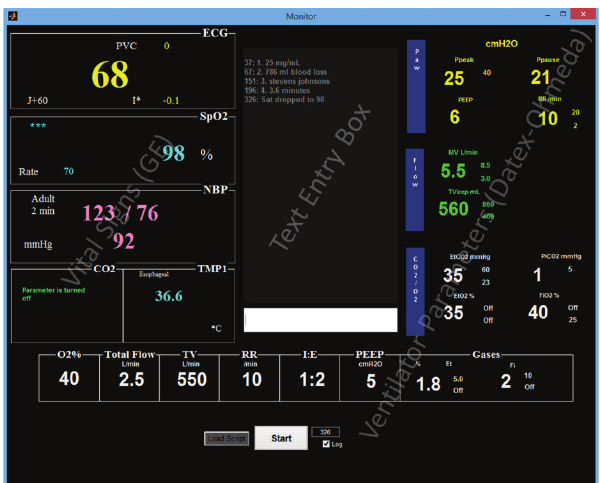
Figure 1: Graphical user interface (GUI) used in simulation experiments. Parameters were updated at one-second intervals based on values read from an XLS file. The GUI featured a responsive pulse oximeter auditory display and IEC alarms that would annunciate when parameter alarm thresholds were transcended. Subjects entered answers to distractor questions and responses to state changes in the text entry